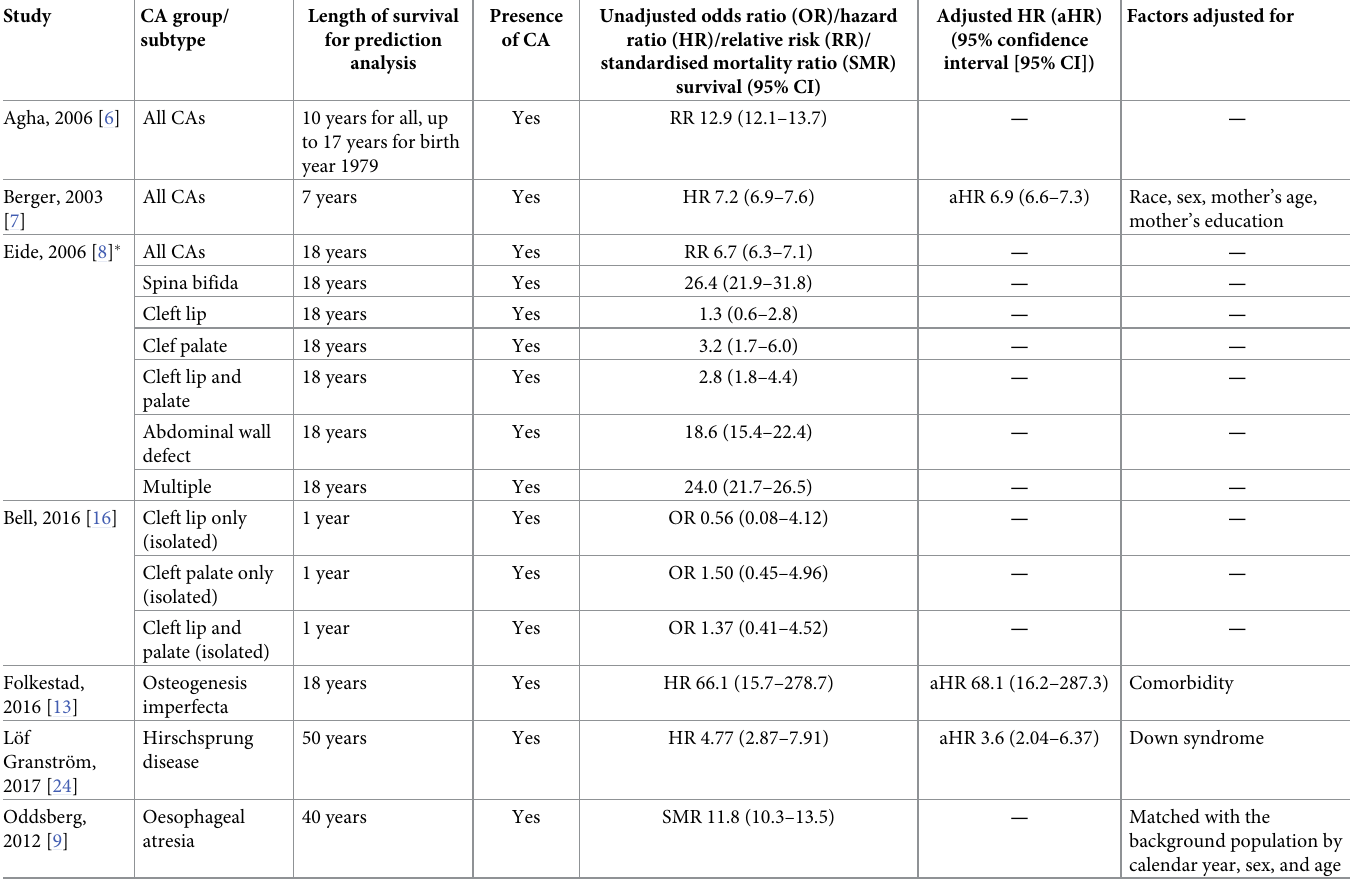
Table 4. Risk of death in children born with a congenital anomaly (CA) compared to the reference population.